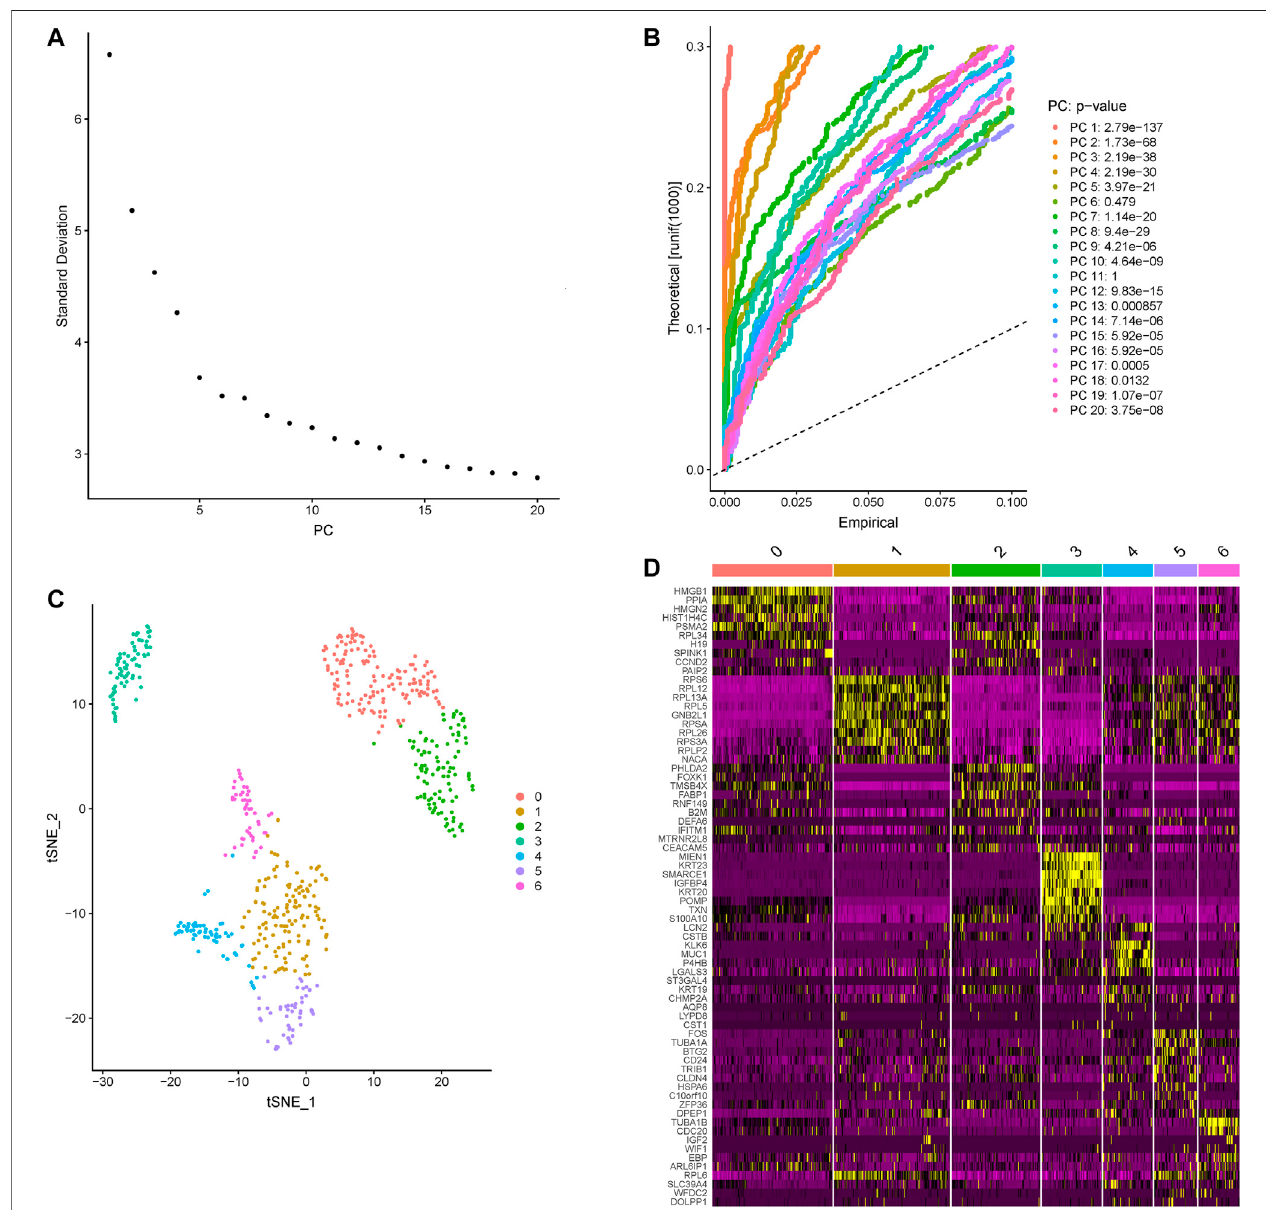
FIGURE 1 | The subtypes clustered across all colon cancer cells. (A) The standard deviations of the top 20 principle components are shown, and the elbow corresponds well withthesigni fi cantdims. (B) Statisticalsigni fi canceofthePCA scoresofthetop20 PCs,the p -valuesare shown ontheright. (C) The clustersofcolon cancer are marked by color. (D) The heatmap of the top 10 differentially expressed genes in each subtype, yellow and purple represent high and low expression separately, the subtypes are marked by number.